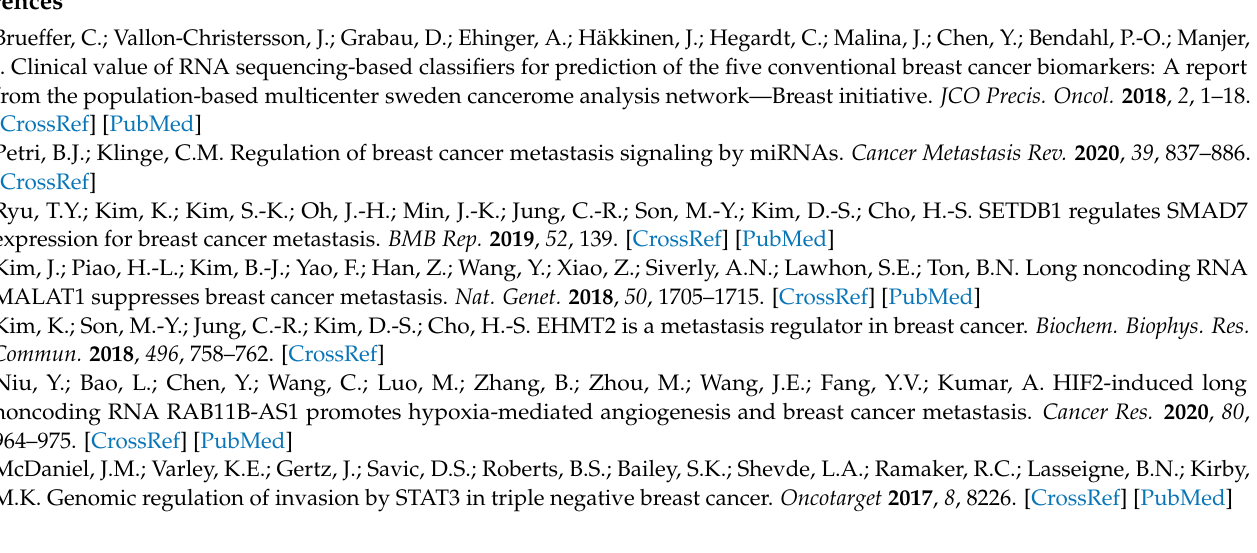
(b). Figure S2. 18 F-FDG PET/CT image deep learning accuracy and loss value, (a) Chemotherapy response prediction, (b) Metastasis prediction. Table S1. The AUC values of image texture features for chemotherapy response from 52 pediatric osteosarcoma. Table S2. The AUC values of image texture features for metastasis from 52 pediatric osteosarcoma. Table S3. 47 image texture features from 18 F-FDG